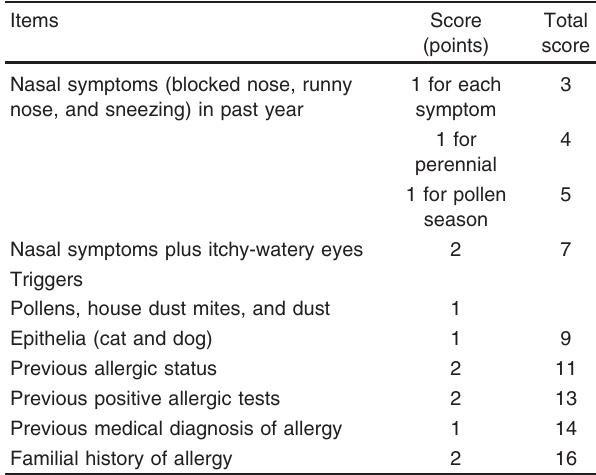
Table 1 Self-completed questionnaire for the scoring for allergic rhinitis